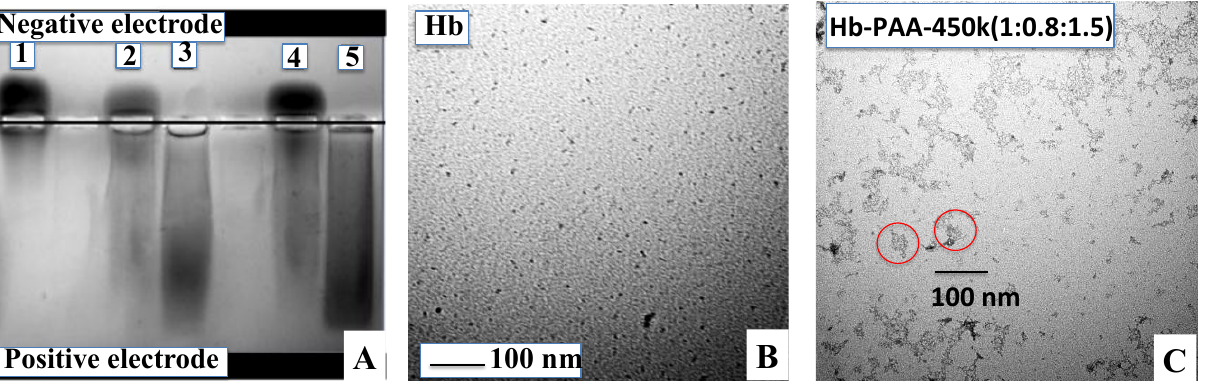
Figure 1. Covalent conjugation of Hb with PAA shown by agarose gel and TEM’s. ( A ) Agarose gel of Hb and Hb-PAA conjugates (40 mM Tris acetate pH 6.5). Lane 1, Hb; lane 2, Hb/PAA-450k(1:0.8:1.5) physical mixture; lane 3, Hb-PAA-450k(1:0.8:1.5); lane 4, Hb/PAA-450k(1:0.3:1.5) physical mixture, and lane 5, Hb-PAA-450k(1:0.3:1.5). Hb migrated towards negative electrode (lane 1) and Hb-PAA migrated (lanes 3 and 5) towards the positive electrode due to the negatively charged carboxyl groups of PAA conjugated to Hb; ( B ) TEM image of Hb ( C ) TEM image of Hb-PAA-450k(1:0.8:1.5) showing nanogels (also shown in circle). All TEM’s are after staining with uranyl